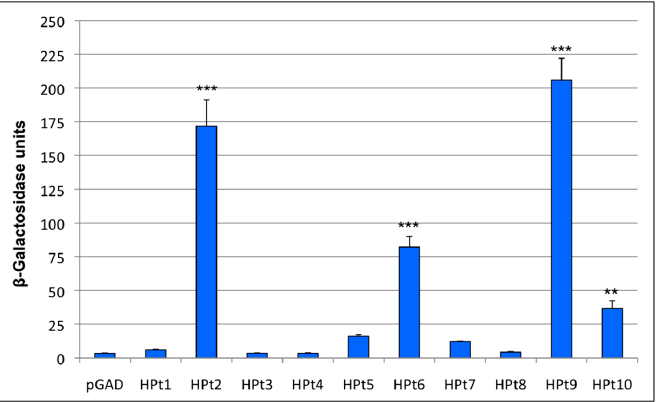
Figure 3. Two-hybrid quantitative tests. β -Galactosidase activity for each HK1b-RD/HPt interaction is plotted with mean values of at least four independent assays performed in triplicate and represented with standard error bars. The interaction background control was measured with an empty prey vector (pGAD) and significant differences from this control are represented by ** with p < 0.01 or *** with p < 0.001.